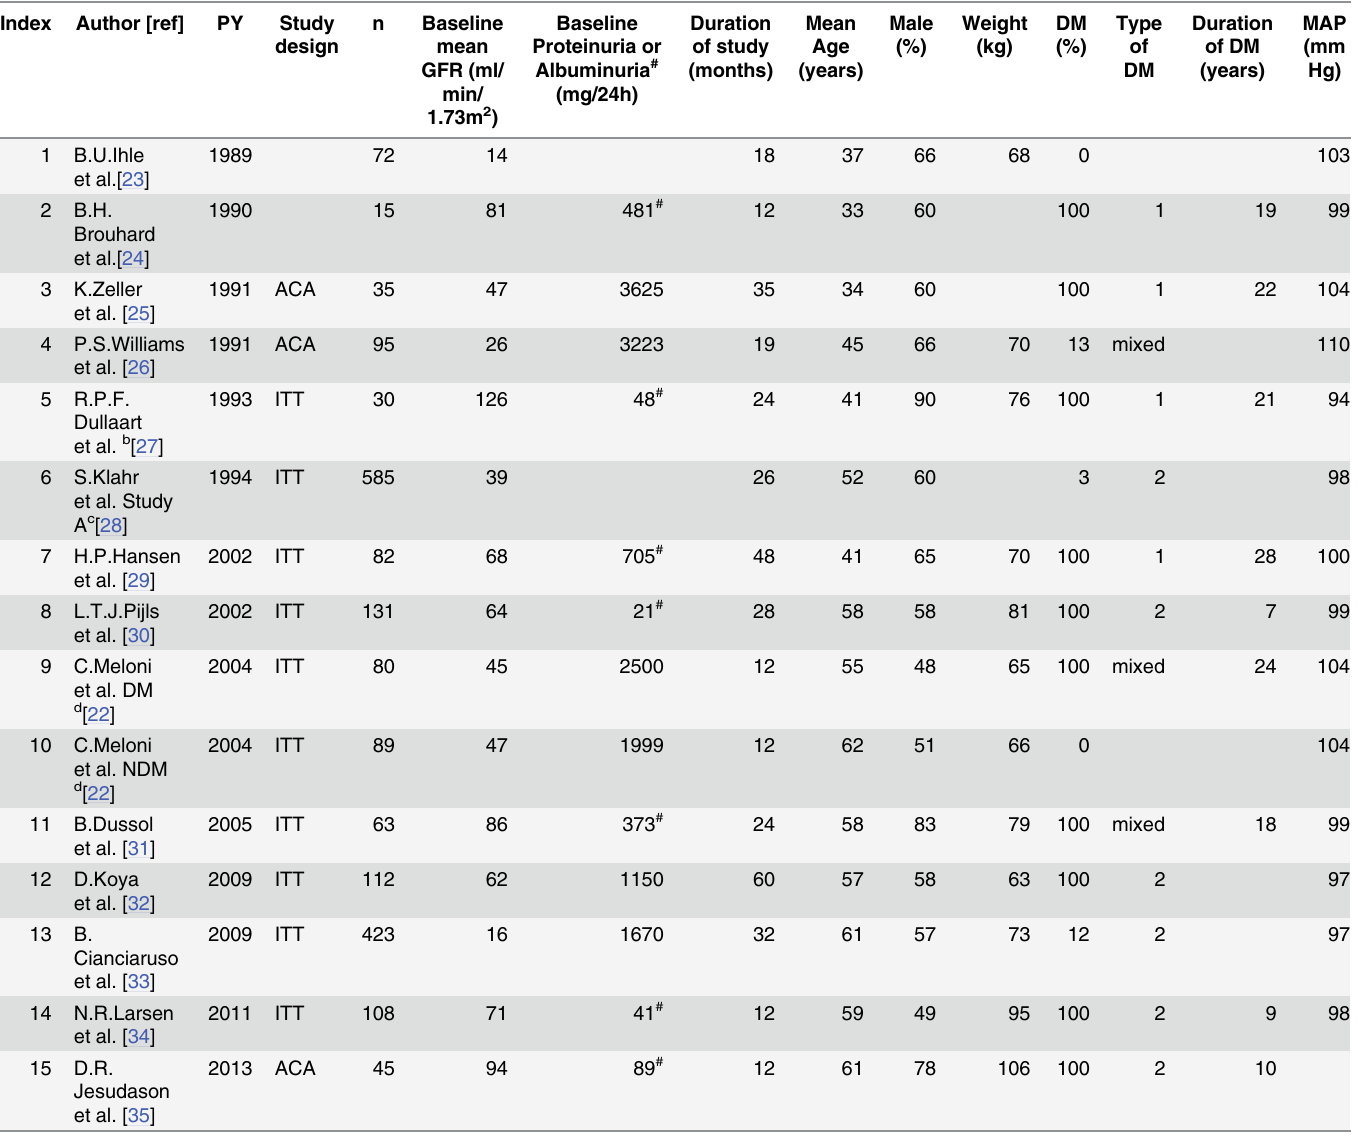
Table 1. Characteristics of the included studies a